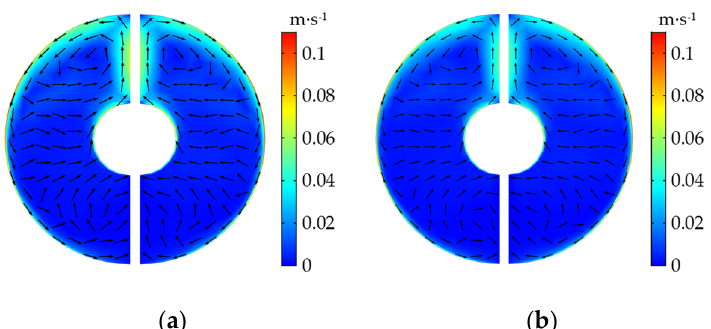
( b ) Figure 9. Surface temperature distribution of the spacer with different SF 6 pressures. As shown in the figure, with an increase in the gas pressure, the temperature of the spacer decreased. A similar tendency in a model without a spacer has been reported by Y. Qiao et al. [19], who showed that with an increase in the pressure, the temperature of the conductor decreased. With an increase in the pressure from 0.4 MPa to 0.6 MPa, the gas density increased from 25.2 to 38.9 kg·m − 3 and the specific heat at constant pressure in- creased from 0.677 to 0.69 J·kg − 1 ·K − 1 leading to the increase in the product of the density and specific heat. Hence, the heat capacity per unit volume increased, and the heat transfer by convection was promoted.